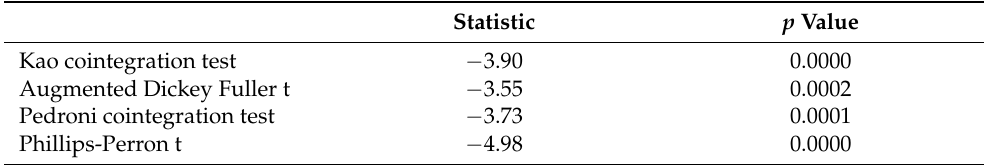
Table 4. Panel Cointegration Tests Results.